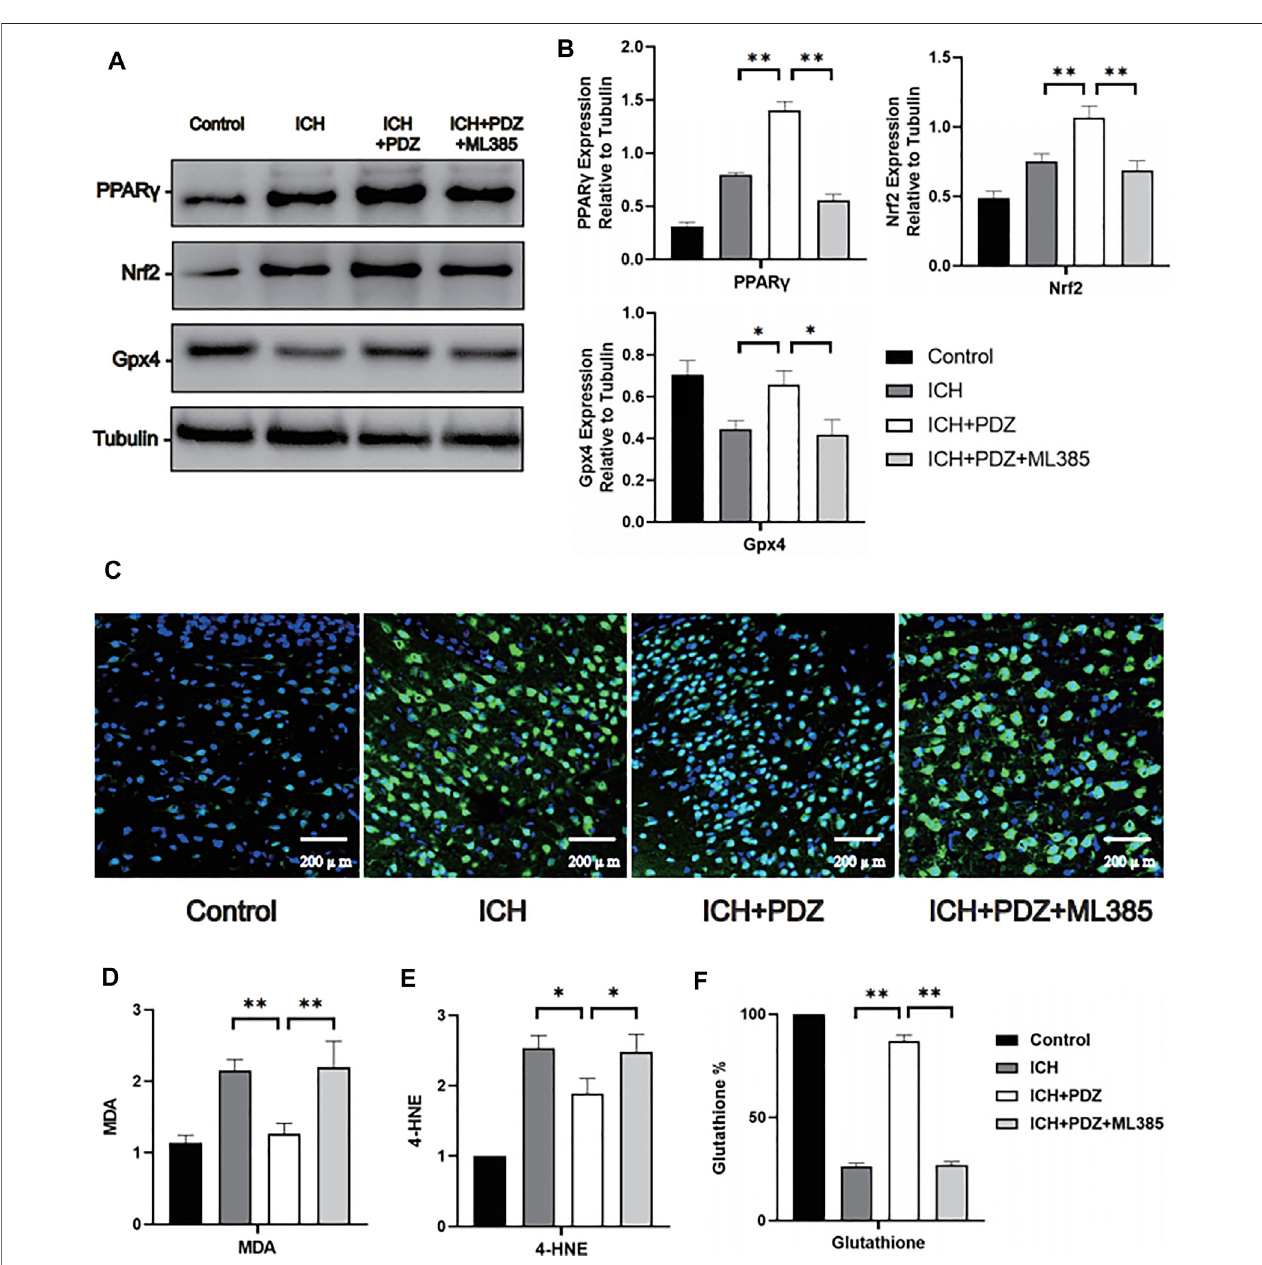
FIGURE5| EffectsofPPAR γ activationonferroptosis-relatedcellularpathways invivo .Sevendaysafter ICH,thebraintissuearoundthehematomawascollected for WB detection, and brain perfusion wasperformed topreparefrozen sections forimmuno fl uorescence staining. (A) Levelsofthe PPAR γ , Nrf2and Gpx4 proteins. (B) ImageJ software was used to further quantify the gray values of Western blot bands. (C) Representative images of Fluoro-Jade C staining of the brain tissue around the hematoma. (D) The kit was used to detect the MDA content in each group (the speci fi c detection method has been described in detail above). (E) The reduced glutathione content in the neurons from each group. Data are shown as the means ± SD of n = 3 samples/group, and at least three independent experiments were performed. Statistical analyses were conducted using two-way ANOVA followed by the Newman-Keuls multiple-comparison post hoc test. * p < 0.01, ** p < 0.01.